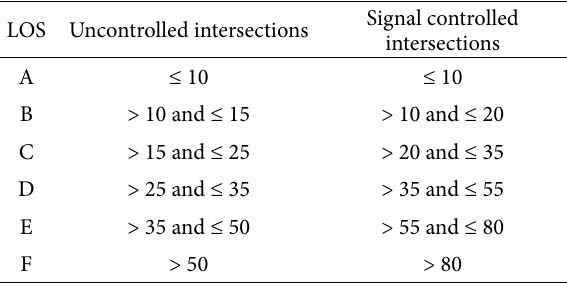
Table 1. Average control delay per vehicle in seconds LOS Uncontrolled intersections